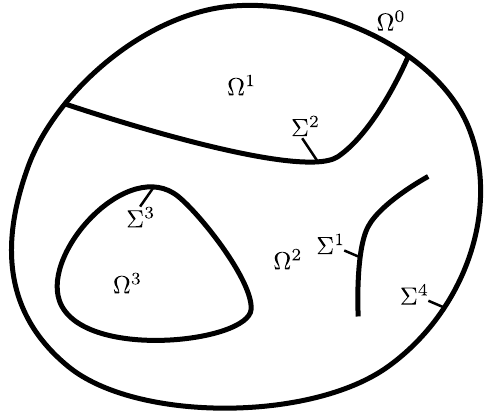
Figure 1. Domain under